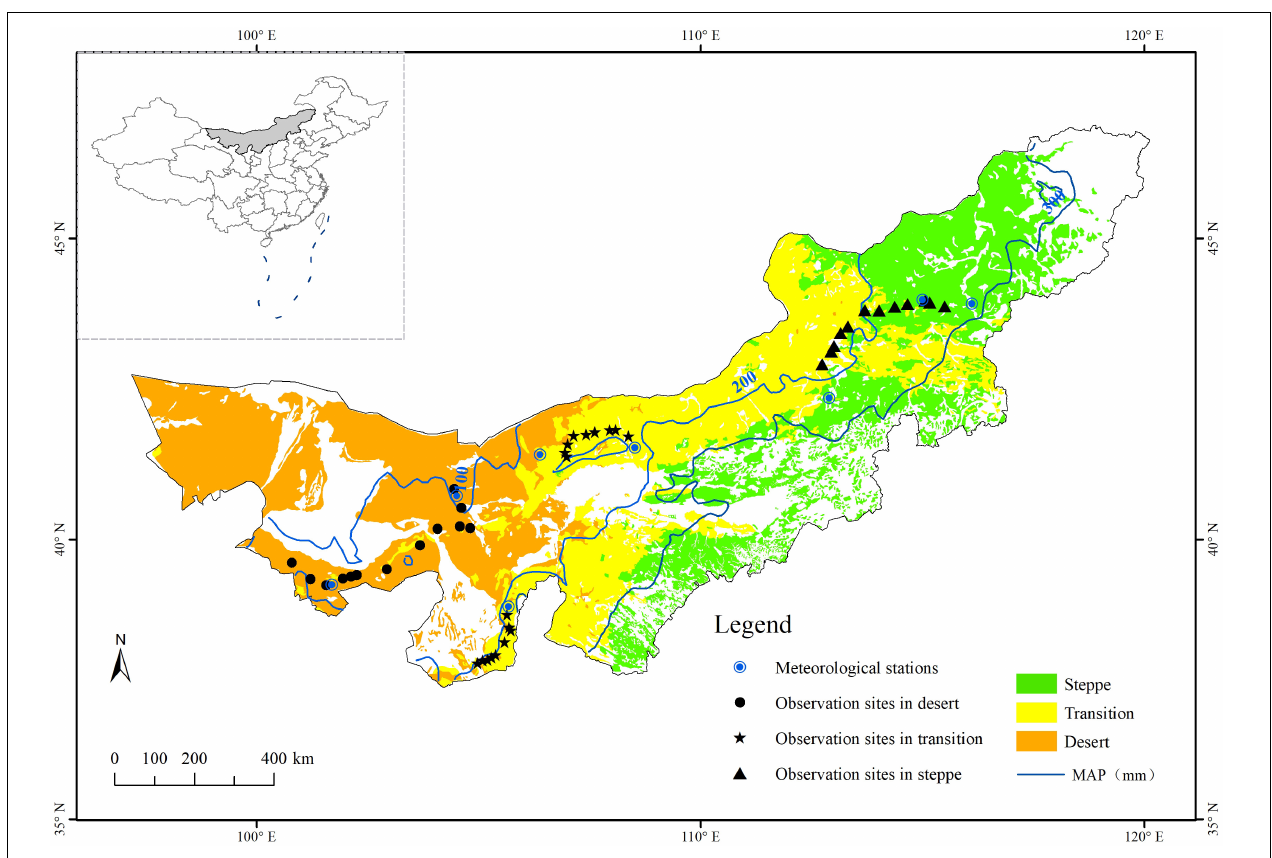
FIGURE 1 | Location of the study area and sampling sites in the desert, transition zone, and typical steppe (Black dots, pentacles, and triangles denote the UAV observation sites in the desert, transition zone, and typical steppe, respectively. Bule circles denote the meteorological stations; MAP represents the mean annual precipitation).